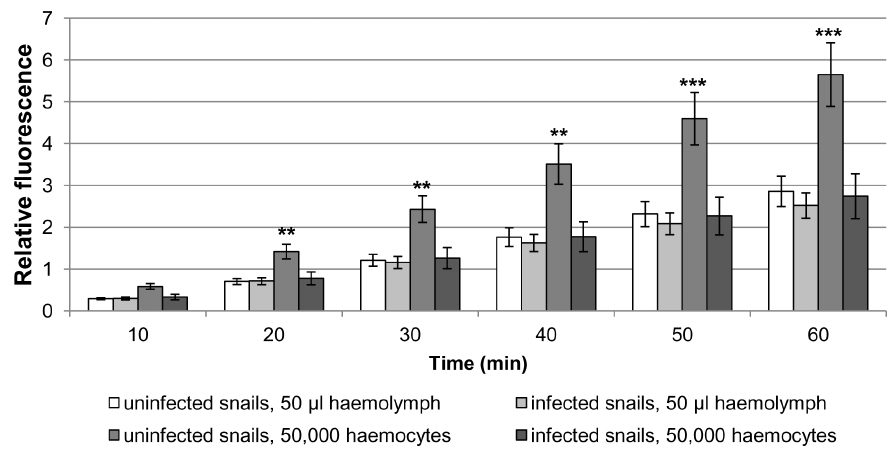
Figure 6. PMA-stimulated H 2 O 2 production in haemocytes from uninfected and Trichobilharziaregenti infected Radixlagotis . H 2 O 2 output by haemocyte monolayers treated with 5 m M PMA was detected by Amplex red and the intensity of fluorescence was measured by microplate reader over 60 min. The mean relative fluorescence values are shown ( 6 SEM; n=7) and represent the increase in H 2 O 2 production over time. Data were evaluated per volume of haemolymph (50 m l) and per number of haemocytes (50,000). **p , 0.01, ***p , 0.001, when compared to infected snails (50,000 haemocytes); two-sample t-test or Wilcoxon test combined with Fishers’s combination test.